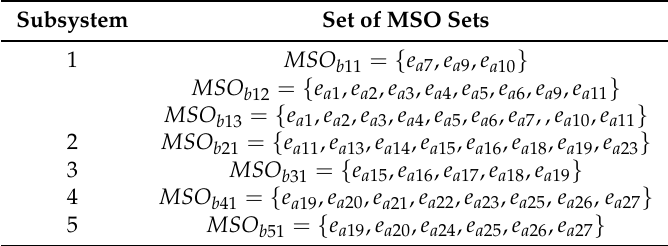
Table 6. Set of MSO sets for each local diagnoser using the equation-based approach.